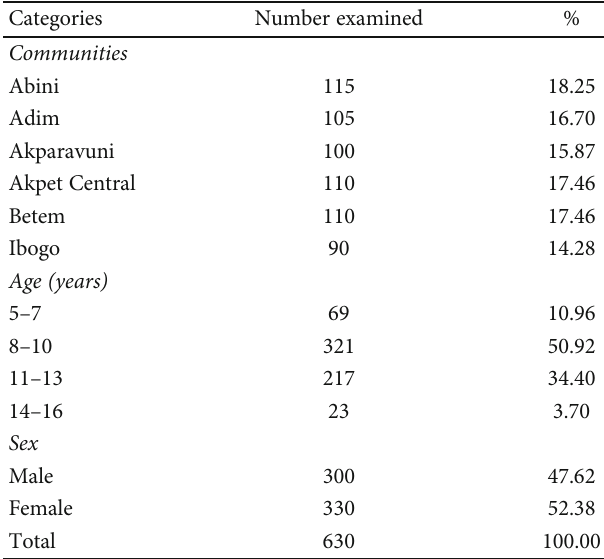
Table 1: Demographic characteristics of school children in Biase LGA, Cross River